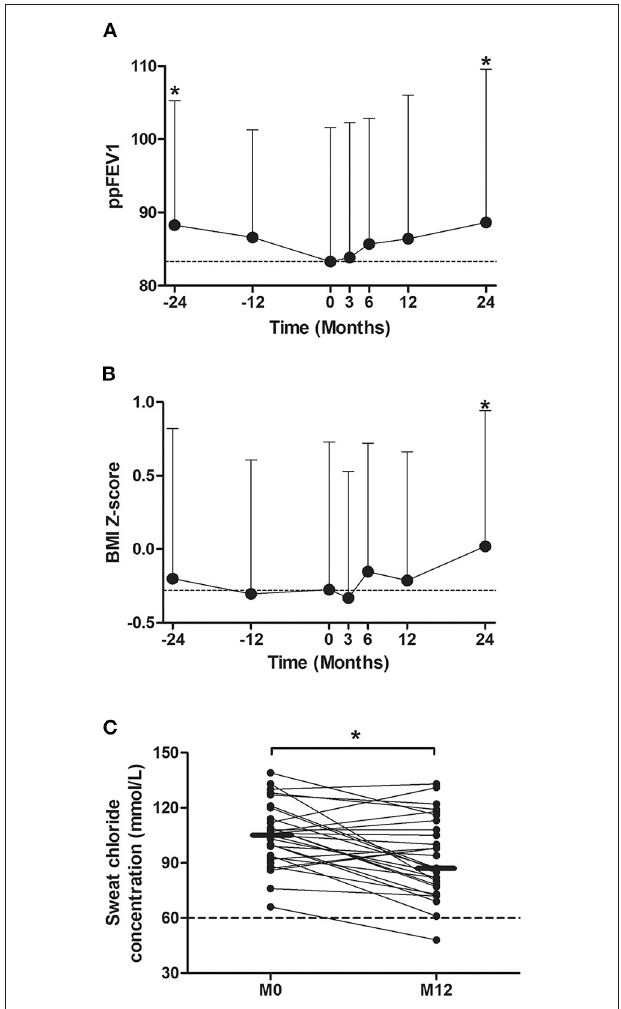
FIGURE 3 | Evolution of the percent predicted forced expiratory volume in 1s (ppFEV1), body mass index (BMI) Z -score, and sweat chloride before and after the initiation of lumacaftor/ivacaftor (LUM/IVA). Evolution of ppFEV1 (A) and BMI Z -score (B) from 2 years before to 2 years after lumacaftor/ivacaftor (LUM/IVA) initiation (M0). Evolution of sweat chloride from M0 to 12 months after lumacaftor/ivacaftor (LUM/IVA) initiation (C) . Data are plotted at each timepoint using all available and were represented at the mean ± standard deviation (A,B) . Comparisons with data obtained at M0 were performed using the Wilcoxon paired test (* p <